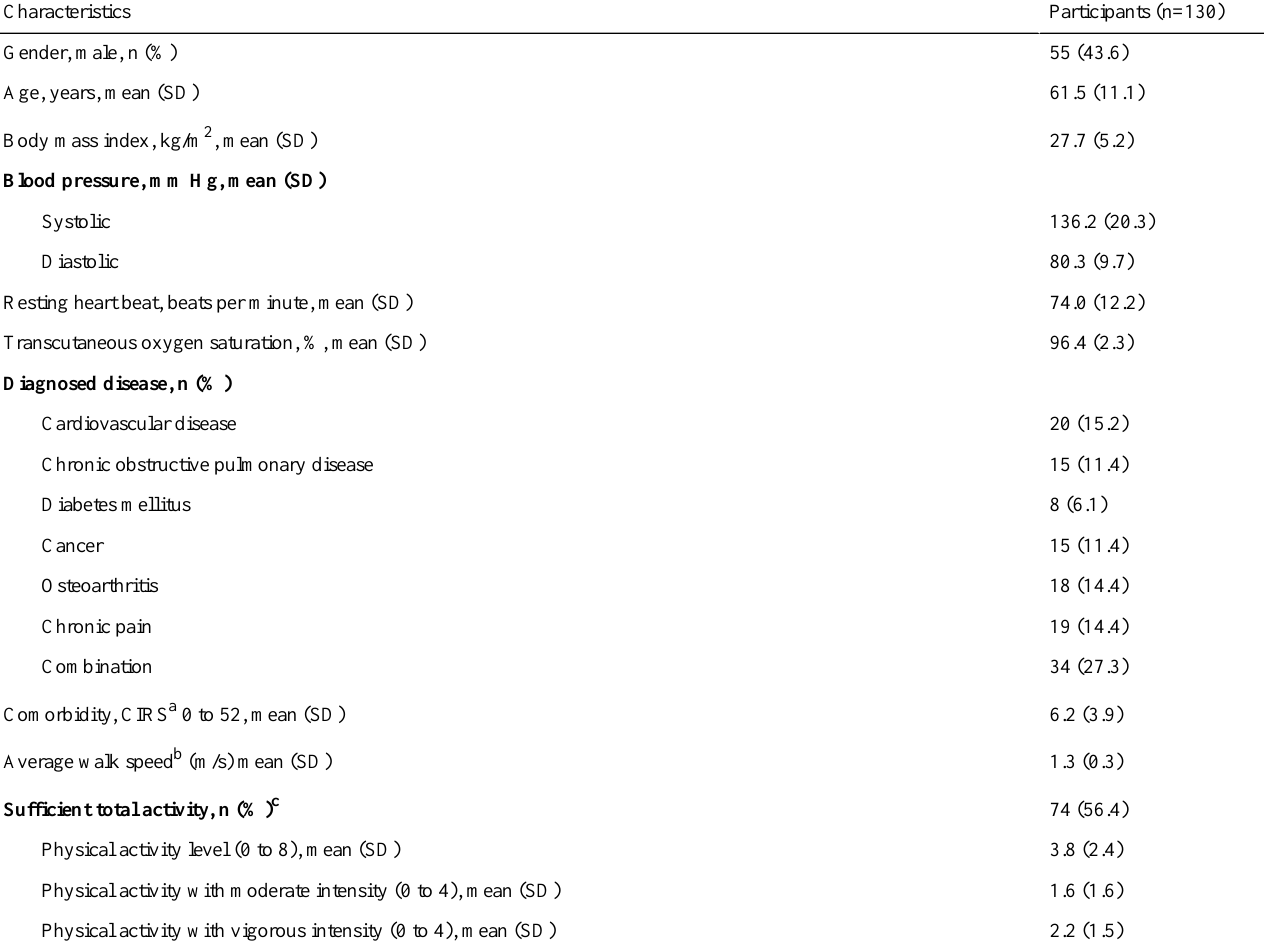
Table 3. Characteristics of the included